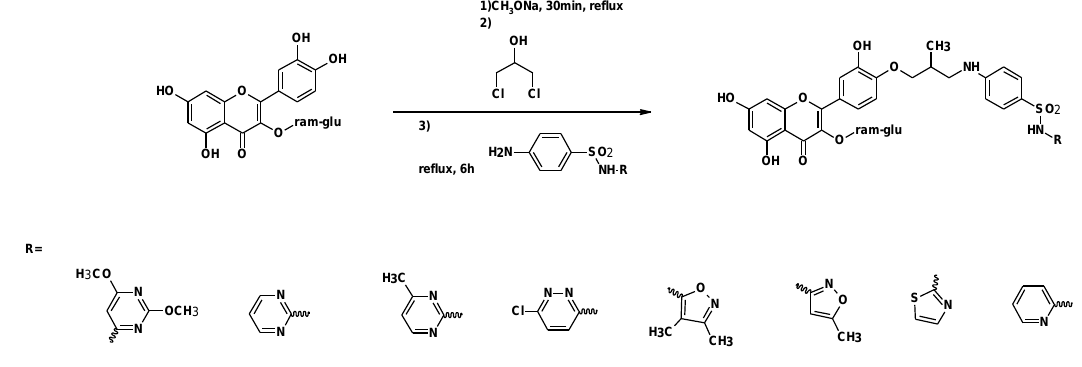
Figure 10. Synthesis of rutine-sulphonamide derivatives, using 1,3-DCH as a linker.